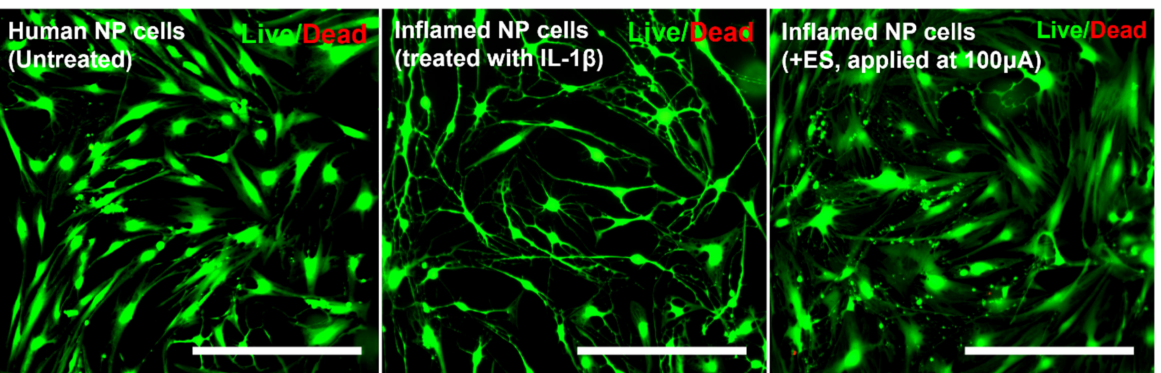
Figure 6. Live and dead viability/cytotoxicity assay depicting the cytotoxic effects of IL-1 β or electrical stimulation in human NP cells. Fluorescence images show viable cells stained with acetomethoxy derivate of calcein (green) and nonviable cells stained with ethidium homodimer-1 (red). Scale bar = 400 µ